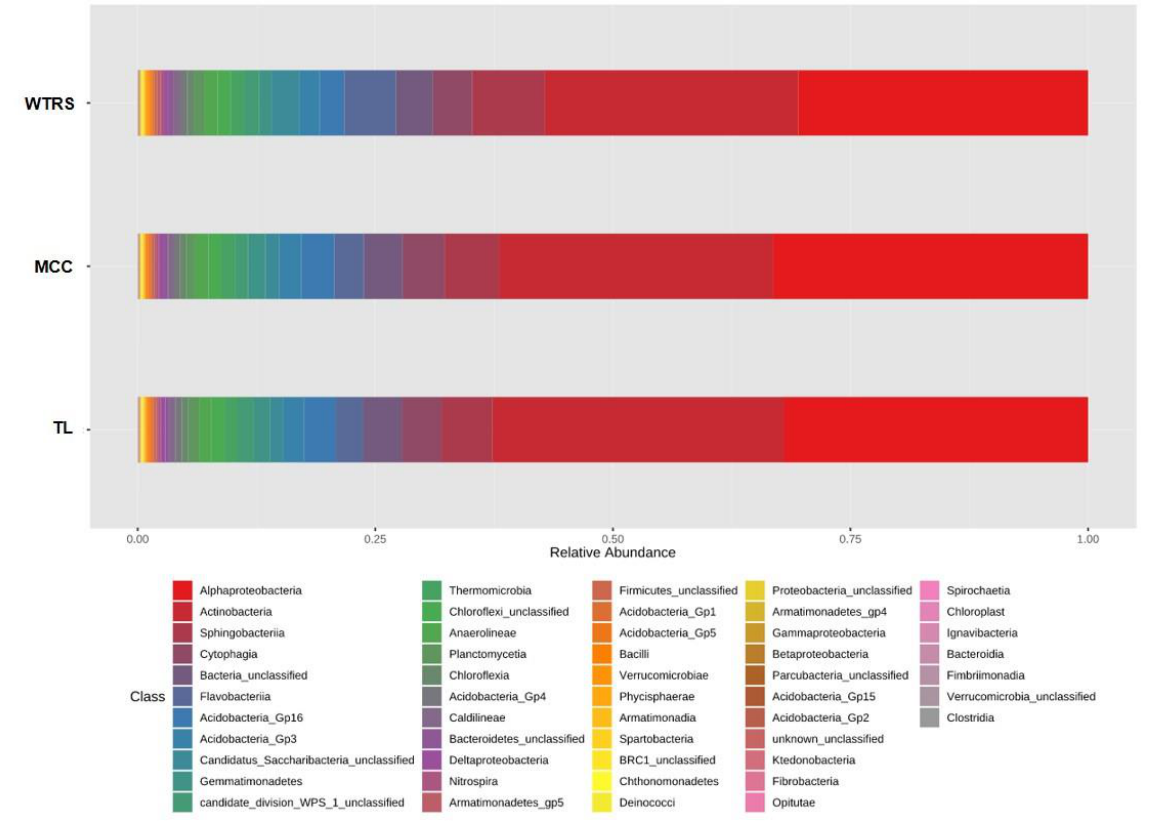
Figure 1. Relative abundance of bacteria of tomato rhizosphere soils. WTRS: wild tomato related species; TL: tomato landraces; MCC: modern commercial cultivars.